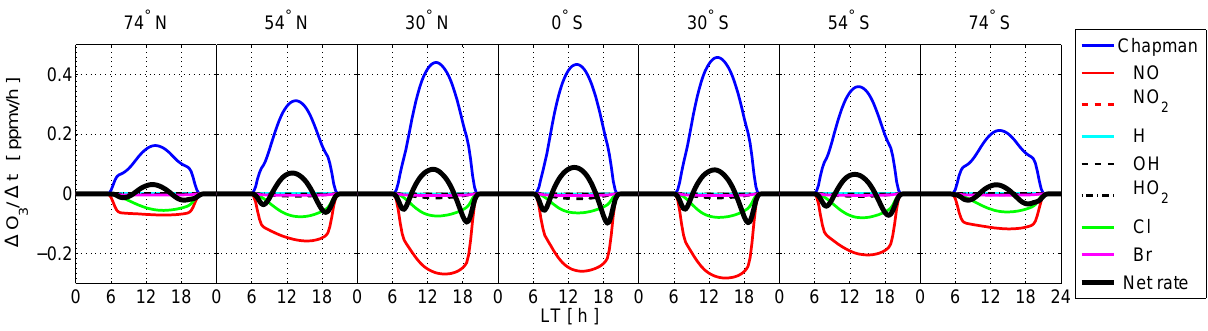
Figure 1. Zonal-mean ozone conversion rates at different latitudes modelled by WACCM (21 March, 5hPa). Sunrise and sunset take place at about 06:00LT and 18:00LT. The conversion rates of the Chapman cycle (blue lines) include production and depletion of ozone according to Reactions (R3–R7). The red and green lines indicate conversion rates based on the NO and Cl catalytic cycles. Further catalytic cycles were taken into account by WACCM but showed negligible ozone conversion rates (catalytic cycles of NO 2 , H, OH, HO 2 and Br). The net conversion rate (black line) is the sum of the conversion rates of all cycles.